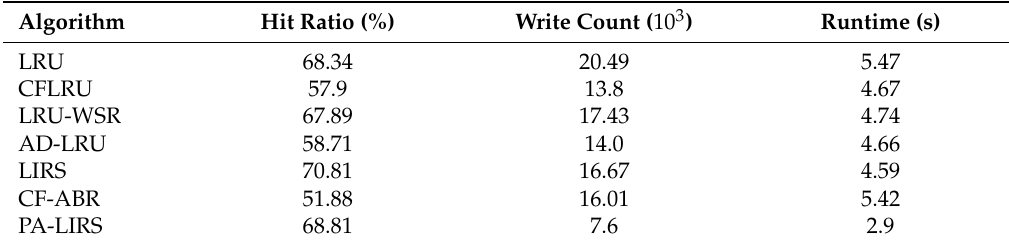
Table 4. Details of the performance comparison under